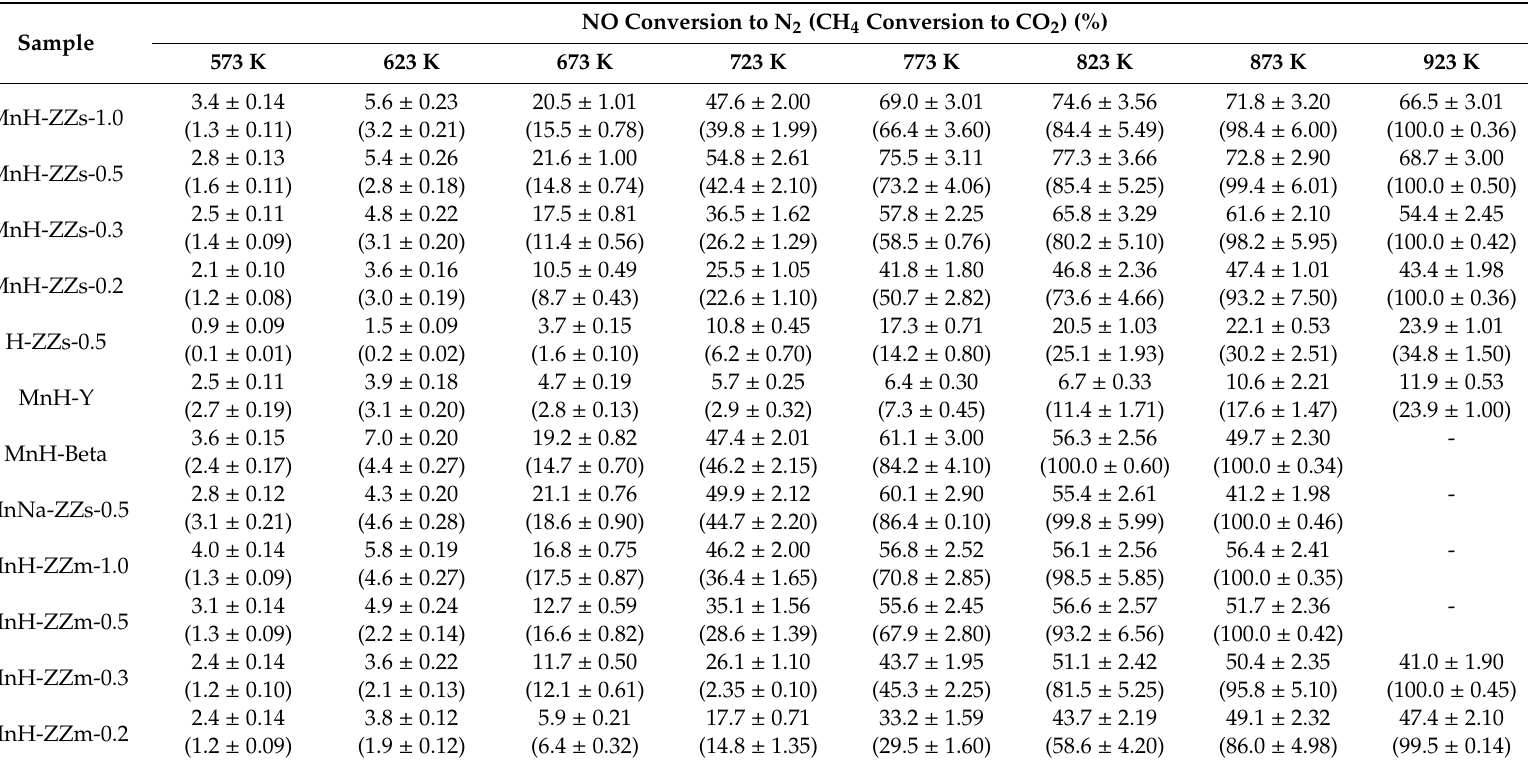
Table 2. CH 4 -SCR activity over MnH-ZZs-n, MnH-Y, MnH-Beta and physical mixture samples in the absence of H 2 O and SO